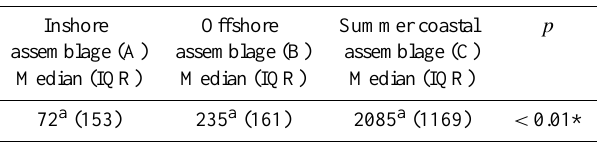
Table 4. Results of the Kruskal–Wallis test and Dunn’s test (post hoc comparisons) for CPUEs of three